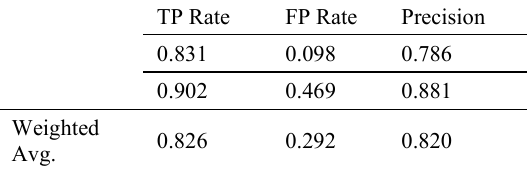
Table 3. Detailed accuracy of